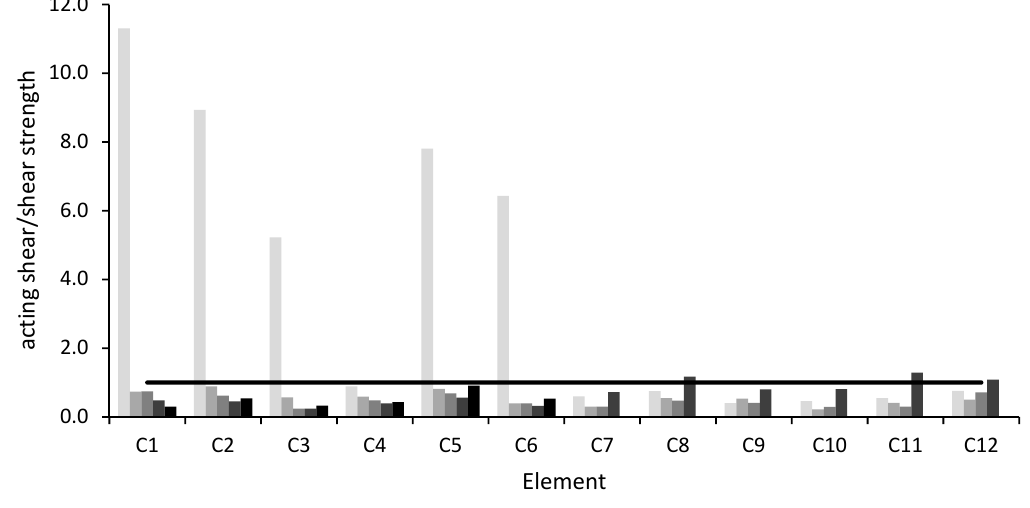
Figure 7. Shear verifications of columns in as-built condition.